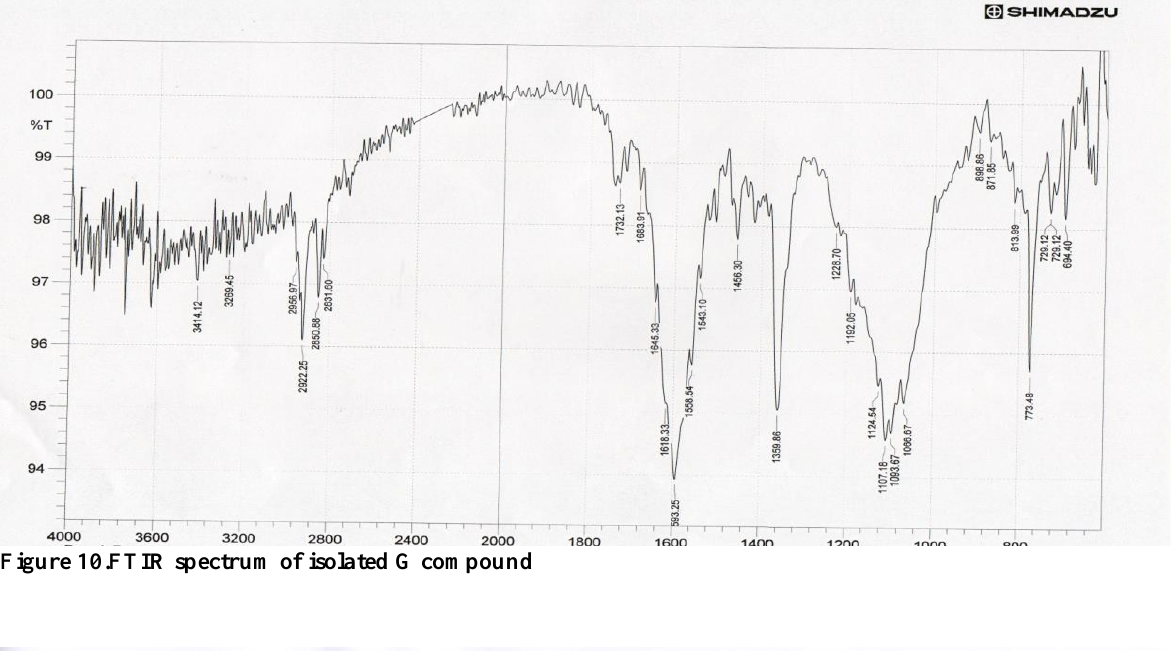
Figure 10.FTIR spectrum of isolated G compound